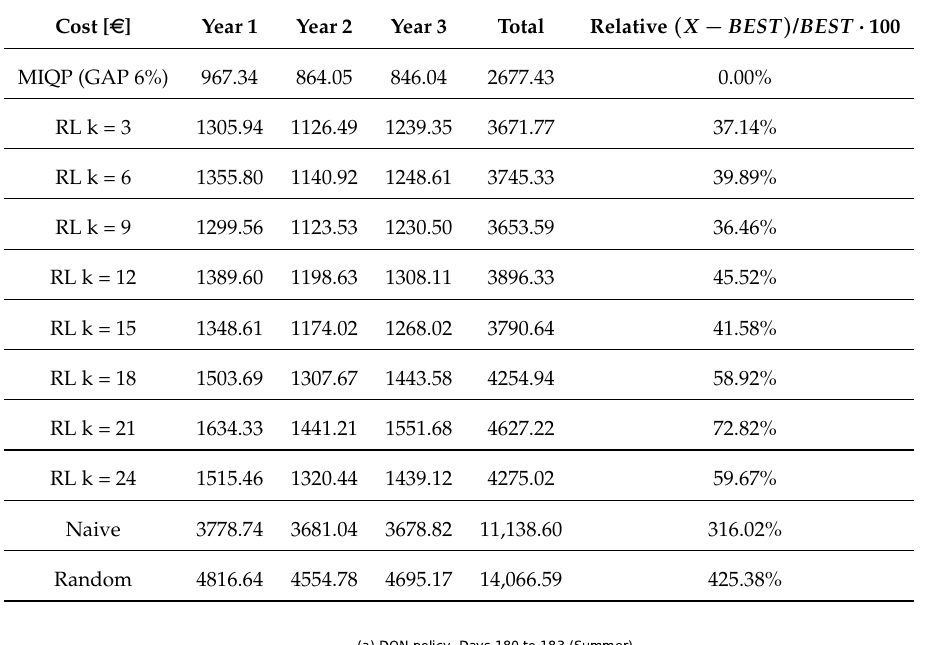
Table 3. Accumulated cost of each algorithm [ e ].